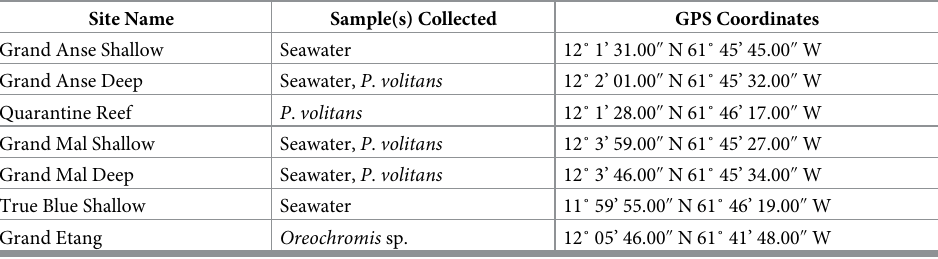
Table 1. Site names, GPS coordinates, and sample type collected in the nearshore waters of Grenada, West